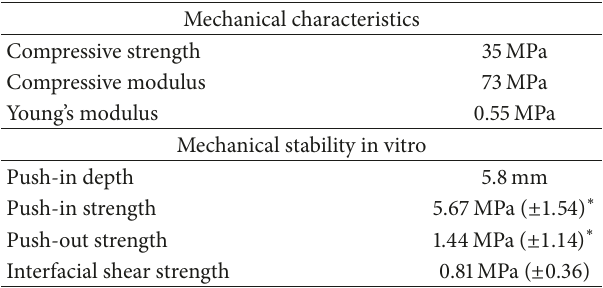
Table 4: Mechanical properties of porous Ti scaffold and its mechanical fixation in Sawbones. Data are expressed as mean ± standard deviation; ∗ shows significant difference at 𝑝 = 0.004